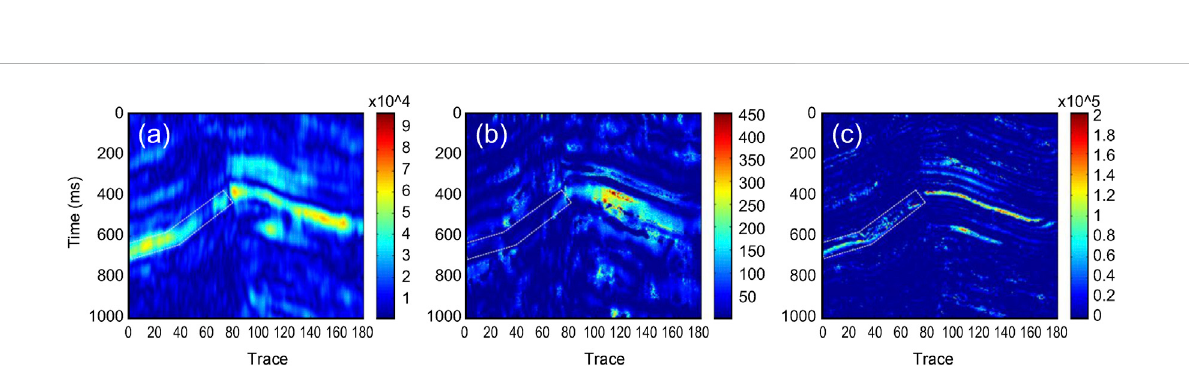
FIGURE 8 30 Hz-isofrequency pro fi le processed with different approaches. (A) Continuous wavelet transform (CWT); (B) CWT-based synchrosqueezing transform(SST);and (C) improvedSST.Thewhitedottedboxmarksthelocationofthegas-bearingreservoir(theseareallplottedwithMATLAB,with the “ jet ” colormap; red indicates higher